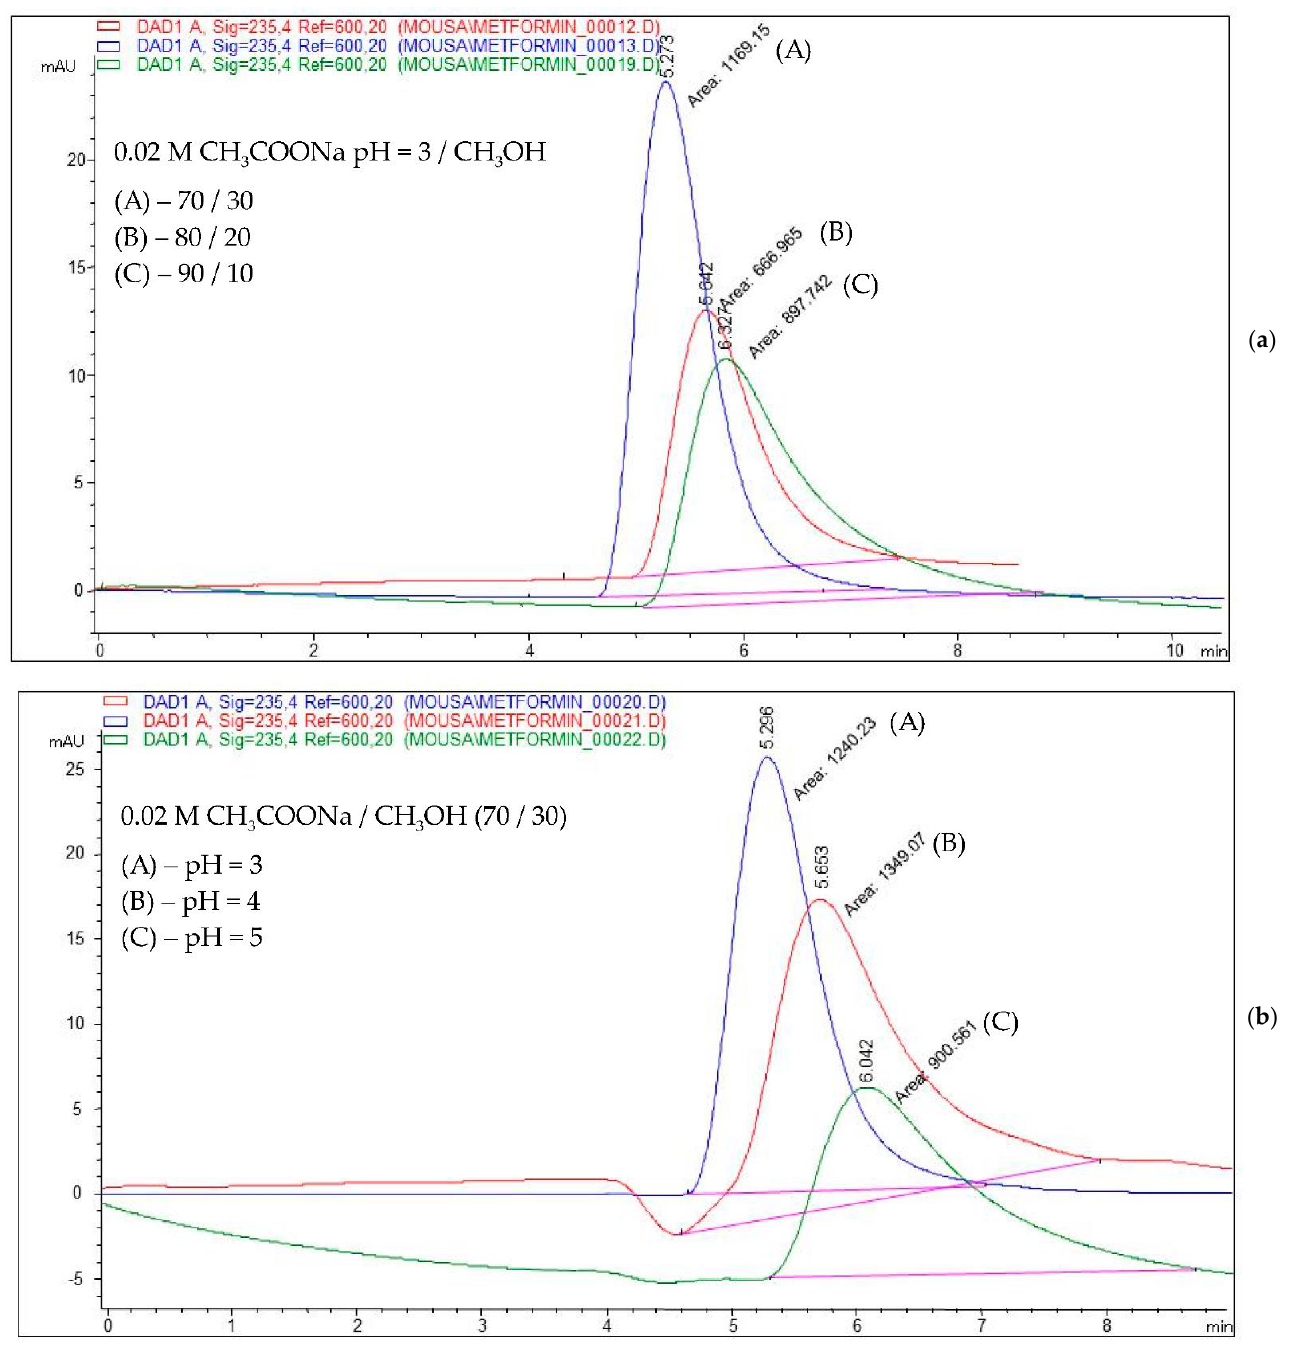
Figure 3. Overlayed chromatograms for a mobile phase consisting of a mixture of ( a ) 0.02 M acetate buffer (pH = 3)/methanol in a ratio of 70/30, 80/20, and 90/10, respectively, v / v ; ( b ) 0.02 M acetate buffer (pH = 3, 4, and 5, respectively)/methanol in a ratio of 70/30, v / v .